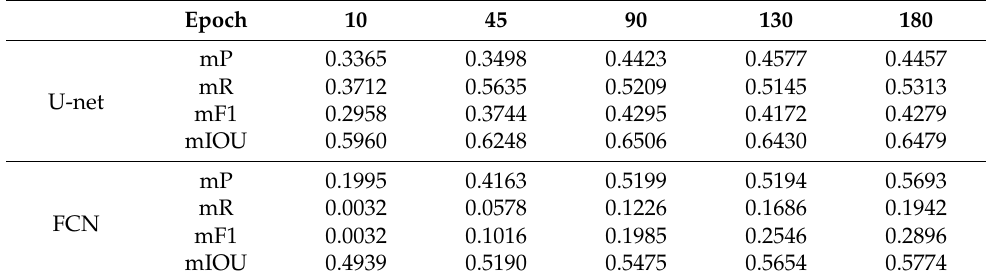
Table 1. Evaluation indicators on test dataset using the trained weight parameters at different epochs.